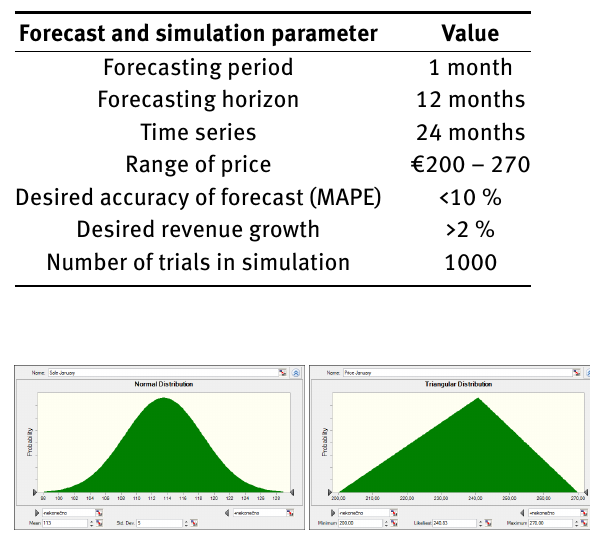
Figure 2: Example of normal and triangular distribution for January sale and